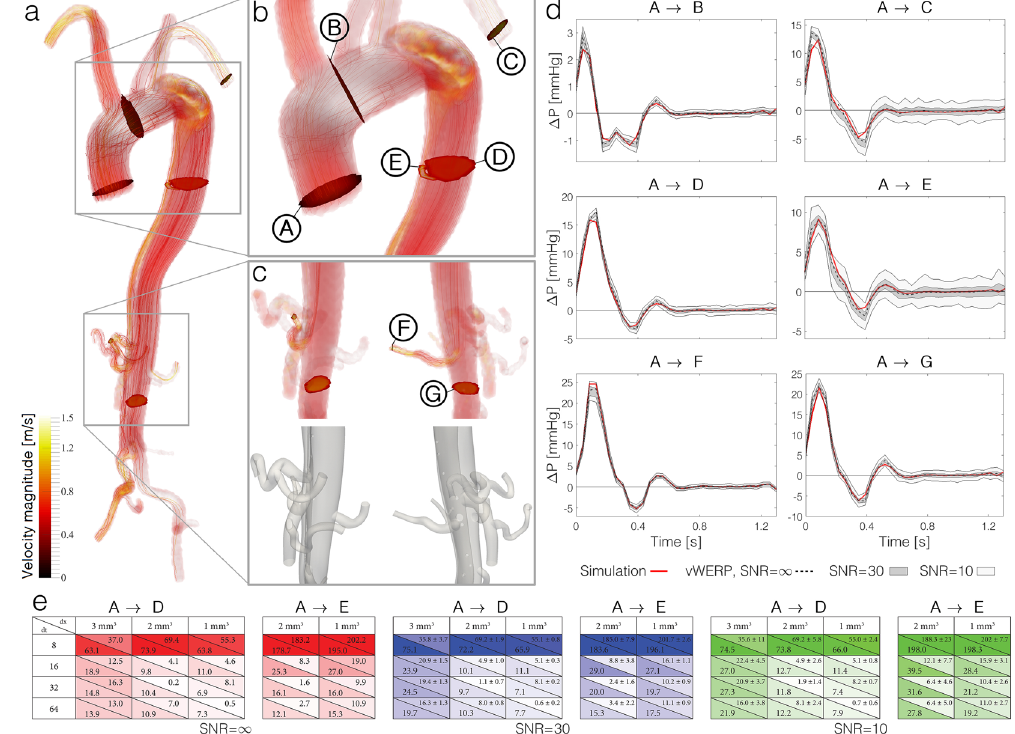
Figure 4. ν WERP relative pressure estimation in a patient-specific dissected aorta, including spatiotemporal convergence analysis. (a) Visualisation of velocity magnitude with streamlines, along with all selected inlet and outlet planes. (b) Close-up visualisation of aortic arch, showing inlet (A), upper descending false lumen (D) and upper descending true lumen (E) planes. (c) Close-up visualisation of outlet planes at the renal artery connecting both true and false lumen (F), as well as at the distal part of the true lumen (G). Views are provided for the same orientation as (a) (left) and as well as rotated 90 degrees (right) (d) Relative pressure estimation from aortic inlet (A) to all selected outlet planes (B – G) as a function of time. True pressure from simulations is given by the red continuous line, ν WERP estimates given by the dashed black, dark gray, and light gray fields, for SNR = ∞ /30/10, respectively. (e) Analysis of spatiotemporal resolution from the aortic inlet (A) to false (D) and true lumen (E). Note that the analysis is only performed when the selected spatial image sampling is able to resolve the anatomy. Data for SNR = ∞ /30/10 is given in red/blue/green, respectively. Each table entry presents the mean error (lower left) and the error at peak relative pressure with standard deviation (upper